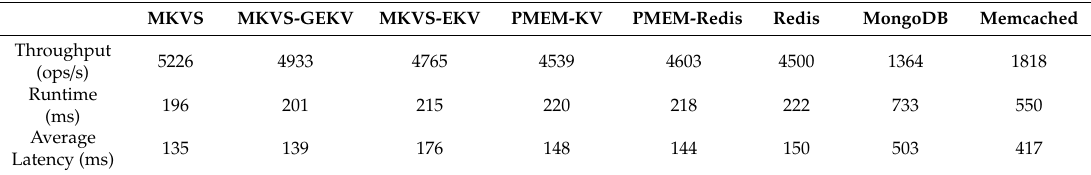
Table 1. The results of inserting 1000 KV pairs.